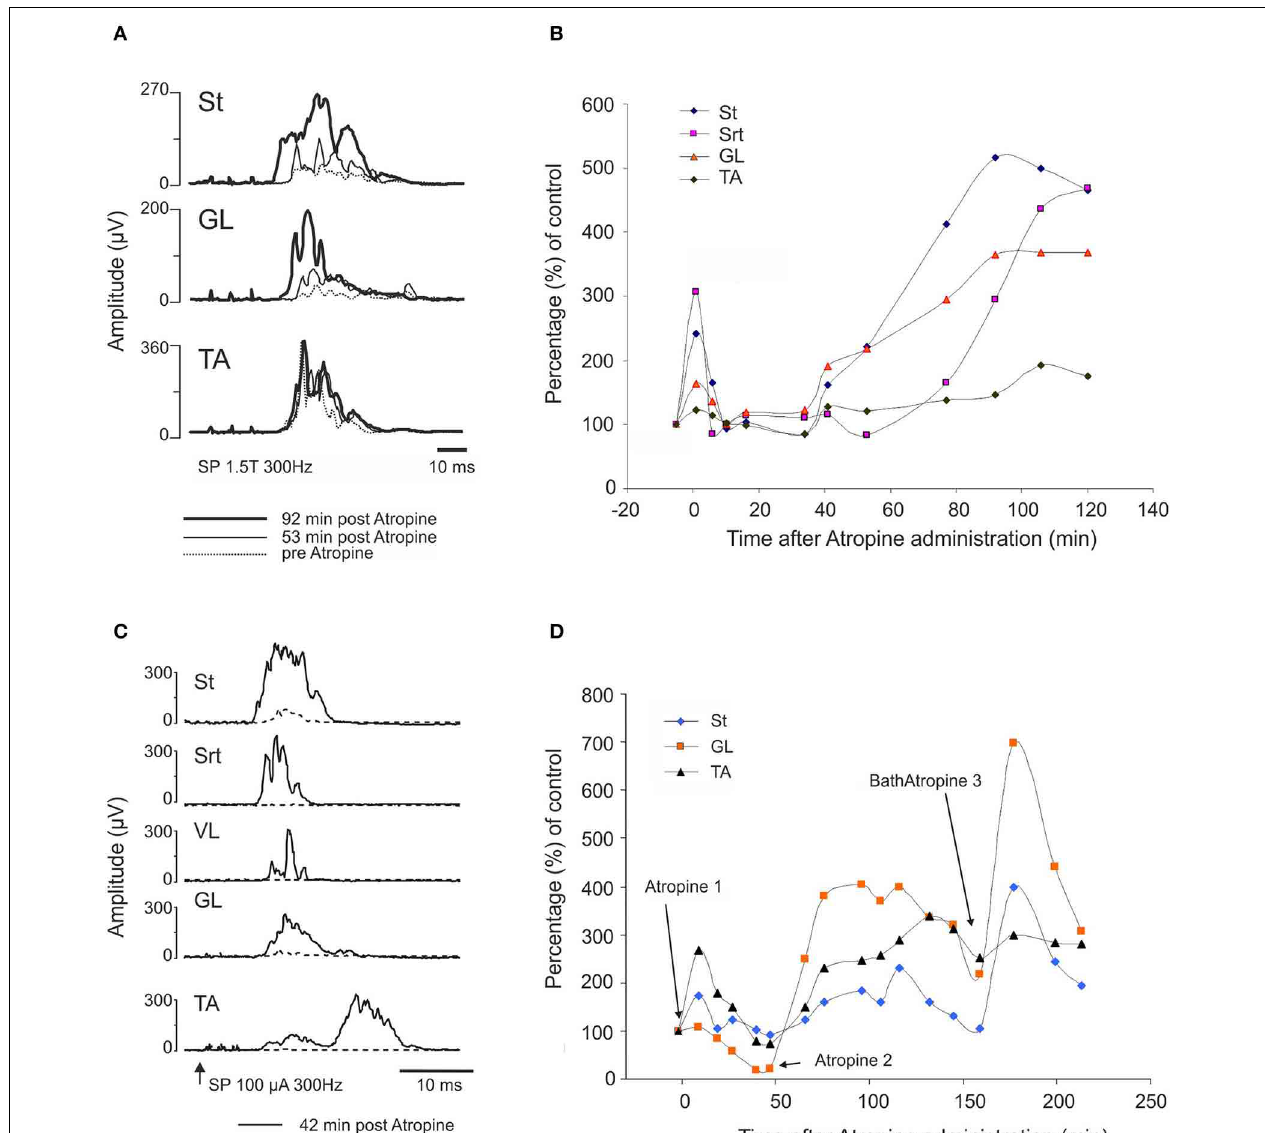
FIGURE 11 | Atropine facilitates the cutaneous reflex responses evoked by stimulation of superficial peroneal (SP) nerve. (A,B) SP facilitation by intrathecal atropine (70 μ g, 100 μ l) 1 day after the complete section of the spinal cord: (A) averaged ( n = 25) rectified response in ST, GL, and TA muscles after stimulation of SP (1.5T, 3 pulses, 300Hz) 300Hz before (dotted line), 53 (thin gray line) and 92 (thick black line) min post atropine; (B)